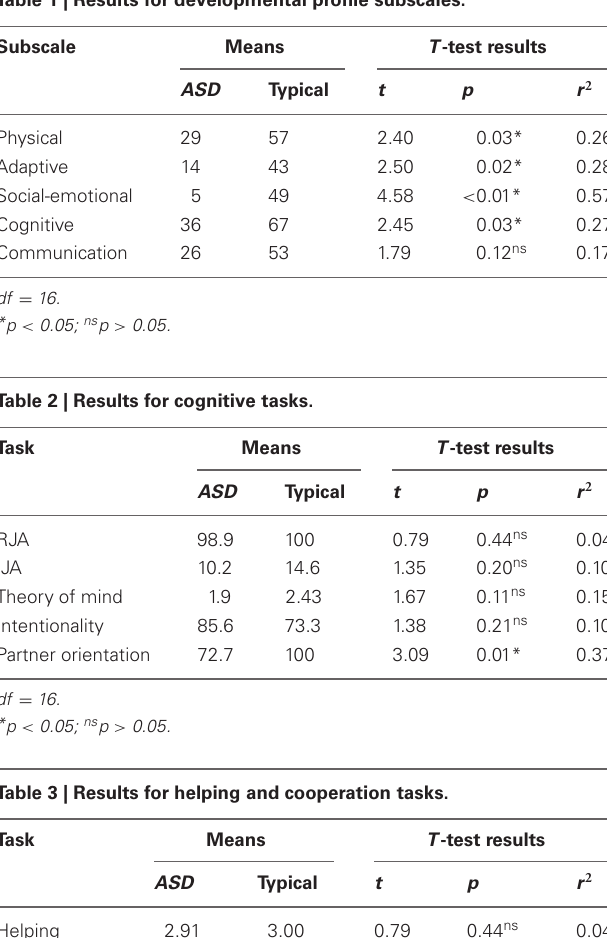
Table 1 | Results for developmental profile subscales.